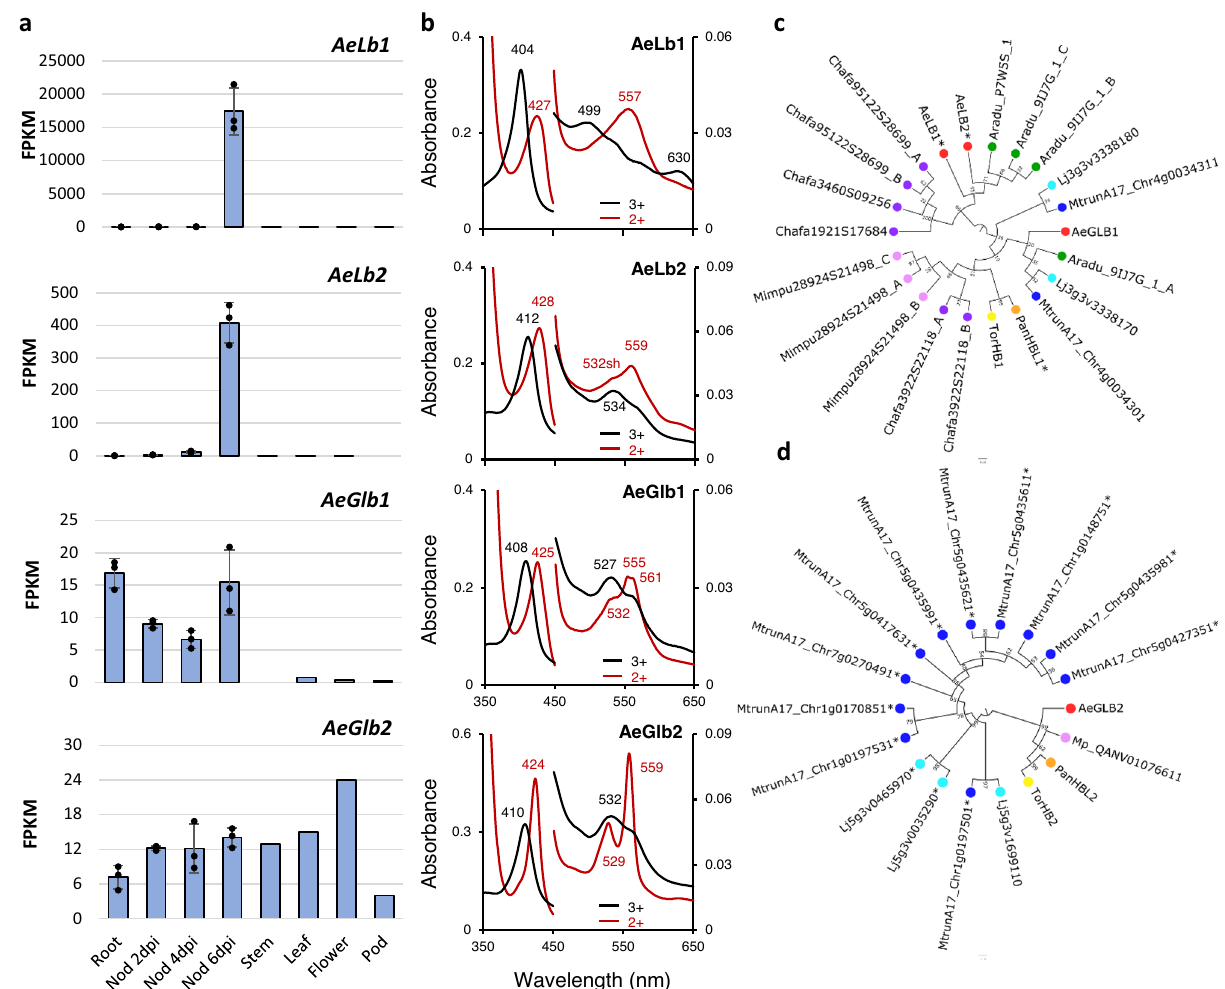
Fig. 5 Symbiotic and non-symbiotic globins of Aeschynomene evenia . a Expression pro fi les of A. evenia globin genes in aerial organs, roots, and nodules (Nod) after 2, 4, and 6 days post-inoculation (dpi) with the Bradyrhizobium strain ORS278. Expression is given in normalized FPKM read counts. For root and nodule samples, data correspond to mean values of three biological replicates ± SEM and dots represent individual expression levels. b UV-visible spectra of A. evenia globins in the ferric (black) and ferrous (red) form. c , d Phylogenetic reconstructions of relationships between Lb, class 1, and class 2 globin genes identi fi ed in A. evenia (Ae), A. duranensis (Aradu), M. truncatula (Mtrun), L. japonicus (Lj), C. fasciculata (Chafa), M. pudica (Mimpu), and the non-legumes P. andersonii (Pan) and T. orientalis (Tor). Node numbers represent bootstrap values (% of 100 replicates). The scale bar represents substitutions per site. Lbs are marked with an asterisk. Source data underlying ( a ) are provided as a Source Data fi symbiotic locus identi fi ed mutations in a gene that encodes a cysteine-rich receptor-like kinase (CRK) 38 , henceforth named AeCRK (Supplementary Table 23). The predicted 658-aa-long protein harbors a signal peptide, two extracellular DUF26 (domains of unknown function) domains, a transmembrane domain (TM), and an intracellular serine/threonine kinase domain (Fig. 7c and Supplementary Fig. 22). In the mutated forms, the G2228A SNP alters a canonical intron/exon splice boundary probably generating a truncated protein while the G1062A SNP leads to the replacement of G354E in the highly conserved glycine-rich loop of the kinase domain (Supplementary Table 20). Allelism tests performed with the two Nod − mutant lines (I10 and J42) indicated that they belong to the same com- plementation group (Supplementary Table 22). Hairy root transformation of the I10 mutant with the coding sequence of AeCRK , fused to its native promoter, resulted in the development of nodules upon inoculation with the Bradyrhizobium ORS278 strain, while no nodules were produced in control plants transformed with the empty vector (Supplementary Fig. 23 and